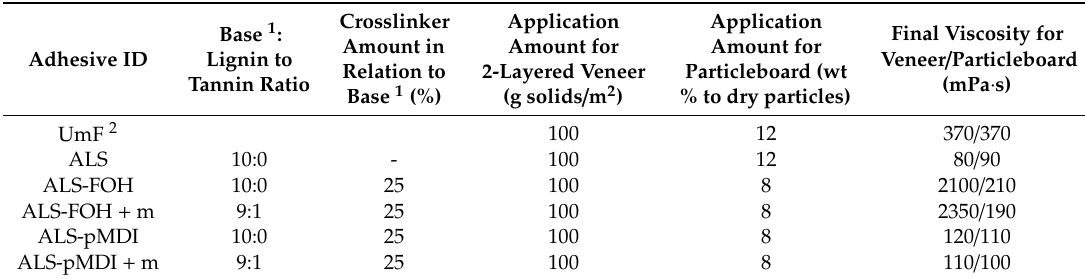
Table 1. Adhesive compositions for testing of 2-layered veneer samples and particleboards based on ammonium lignosulfonate (ALS), furfuryl alcohol (FOH), and polymeric 4,4 (cid:48) -diphenylmethane diisocyanate (pMDI) as crosslinkers, and with or without mimosa tannin (m).